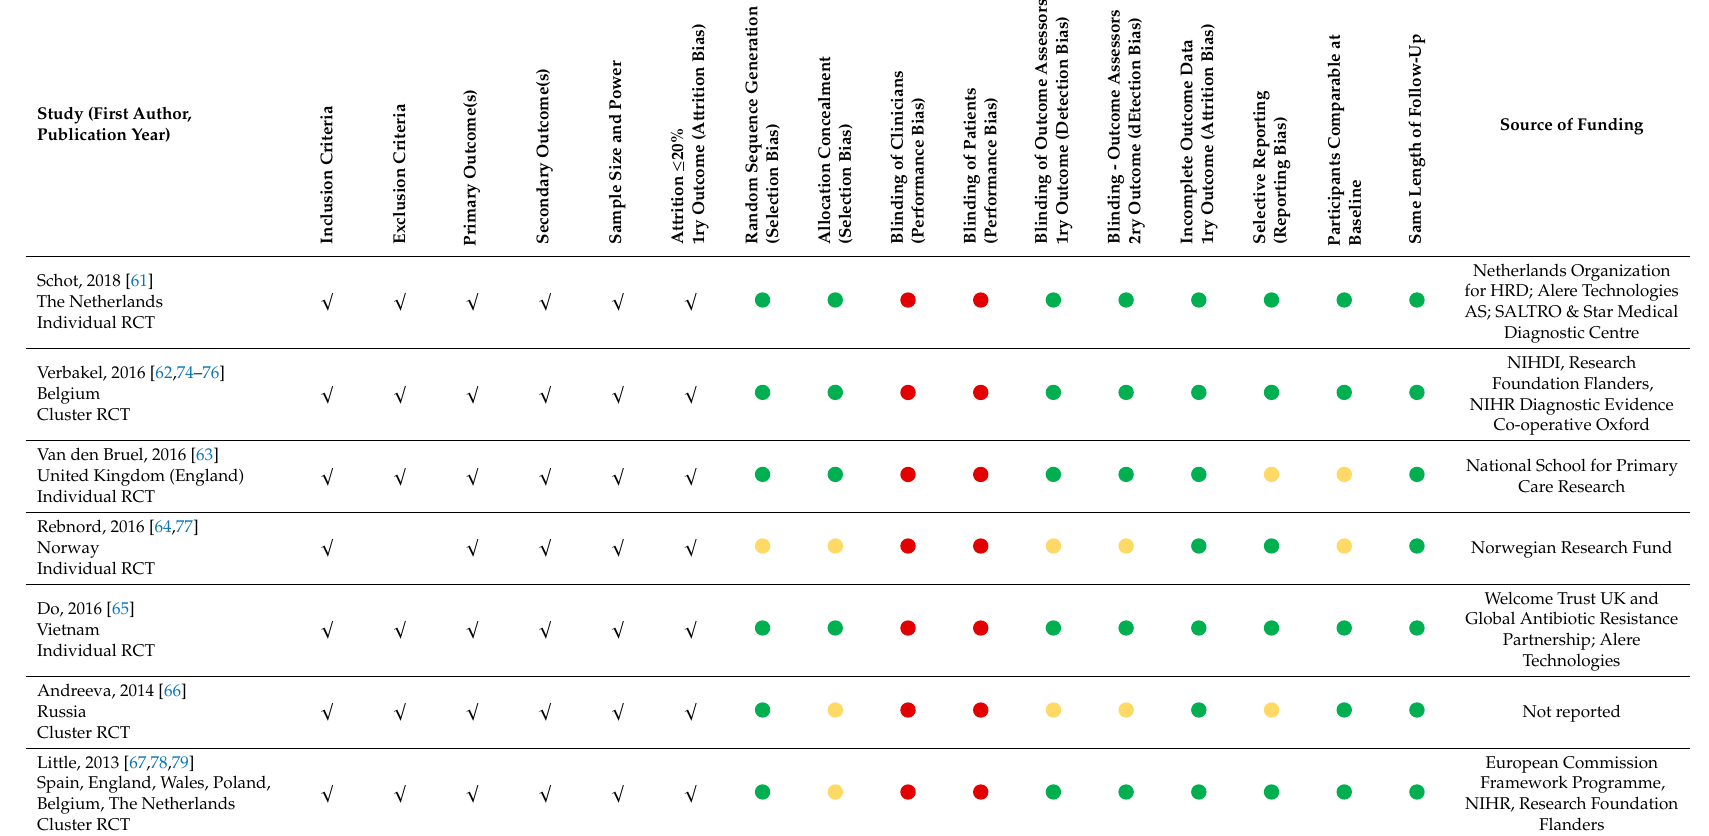
Table 2. Methodological features and risk of bias in the included studies.